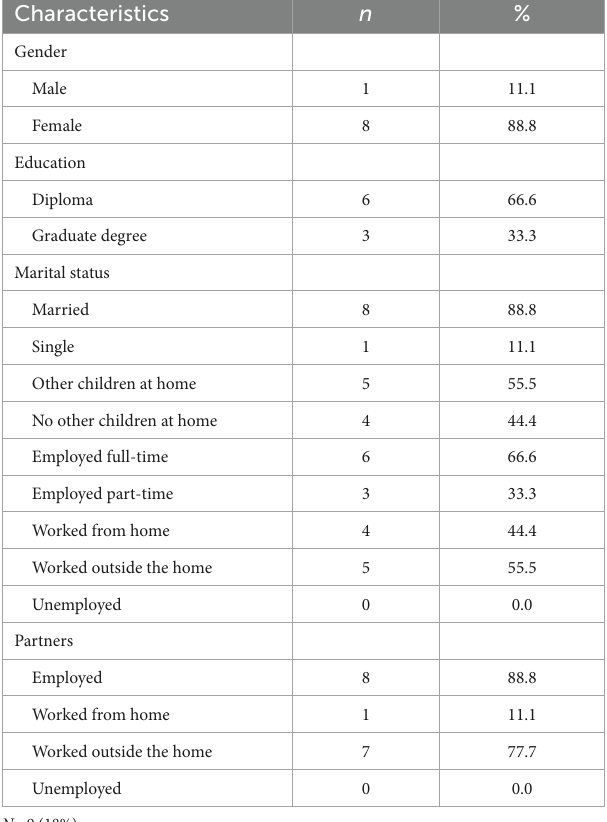
TABLE 1 Characteristics of